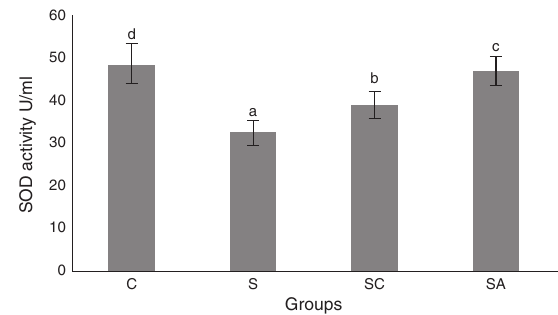
Figure 2 Superoxide dismutase (SOD) activities of the study groups. All groups showed a statistical difference from